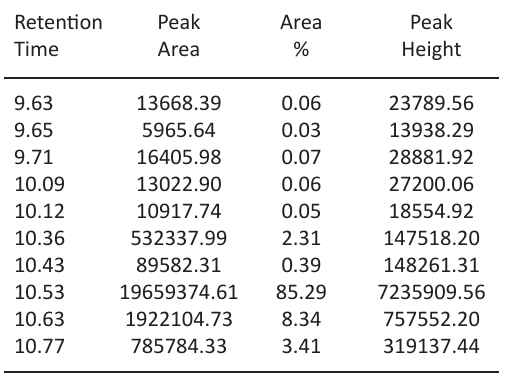
L. plantarum DB-2, P. acidilactici M-3 and P. pentosaceus SM-2. A metabolic compound